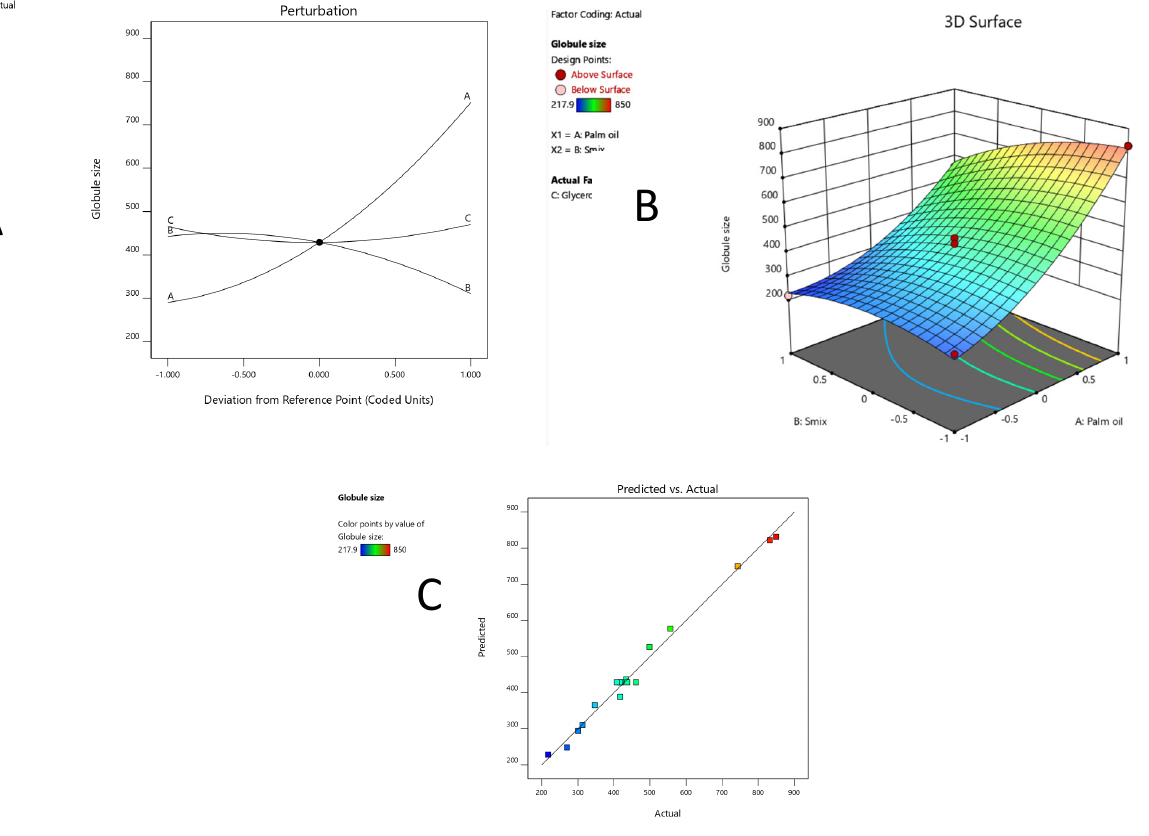
Figure 1. Effect of interaction of independent variables on the droplet size of nano-emulsion formula- tion: ( A ) Perturbation plot, ( B ) 3D surface plot, ( C ) predicted vs. actual